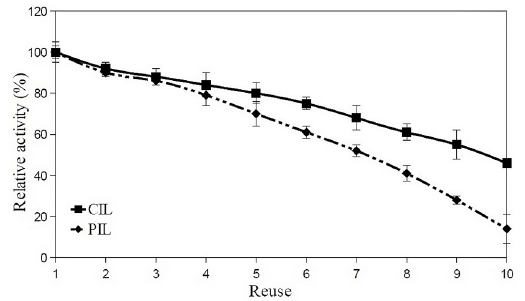
Figure 6: Reuse capabilities of CIL and